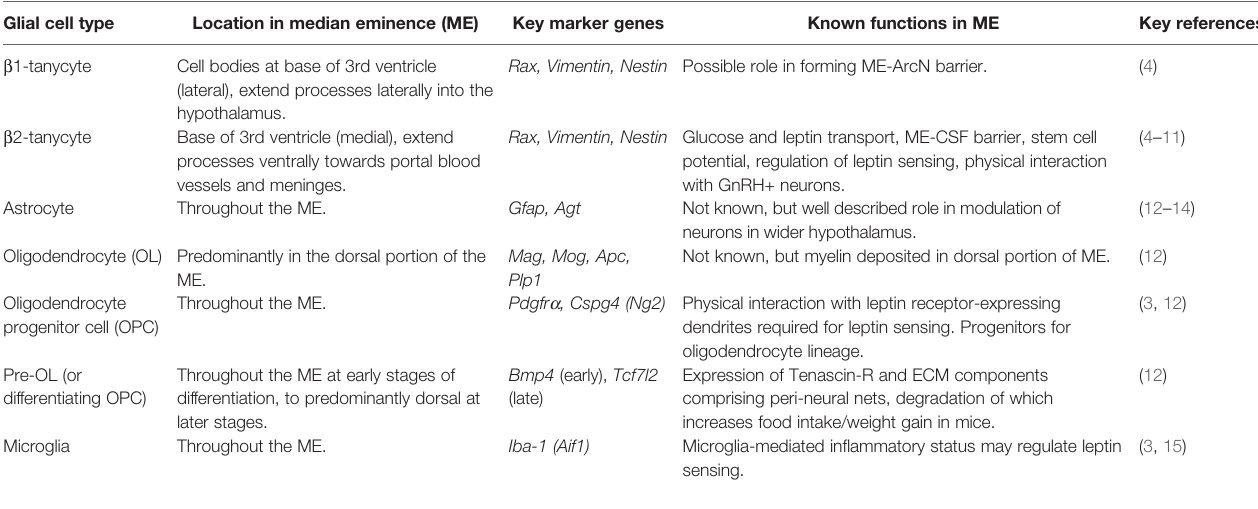
TABLE 1 | Cell types of the median eminence (ME) and their positions, marker genes and known functions. Glial cell